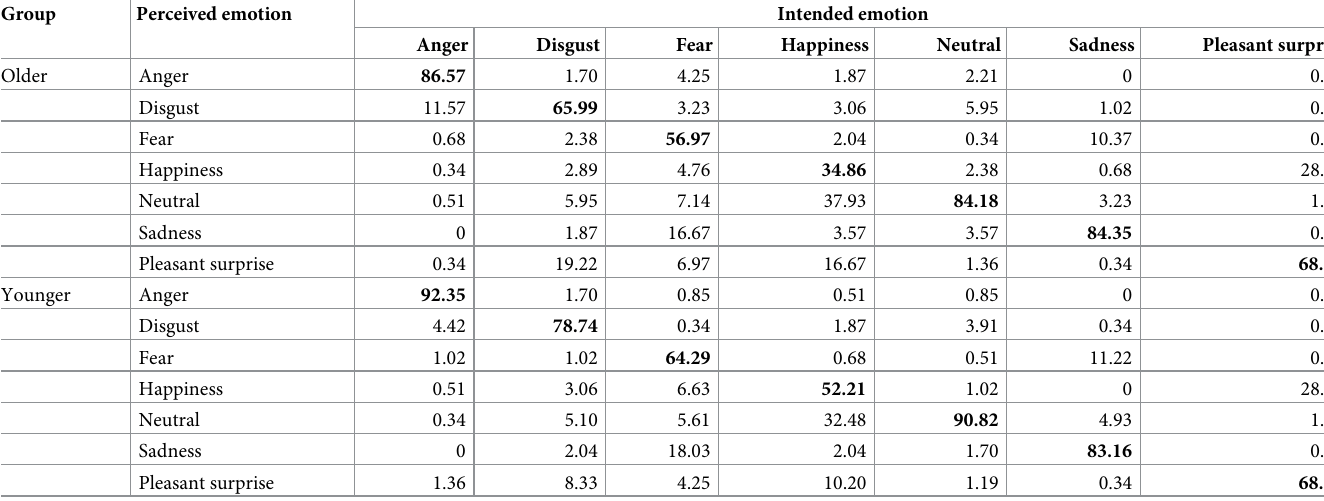
Table 1. Confusion matrix displaying patterns of average accuracy rates (in %) per emotion category (during the EEG study), grouped by age-group. Group Perceived emotion